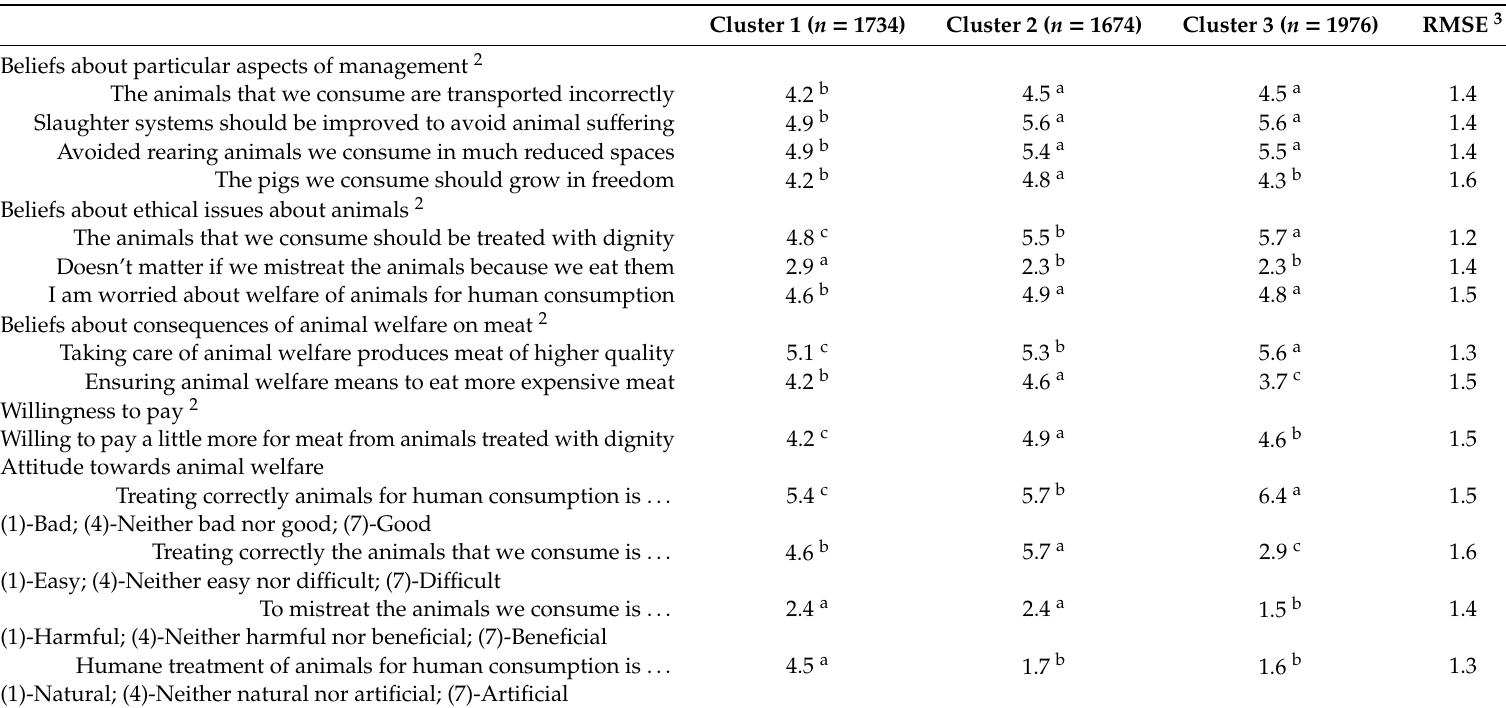
Table 7. Description of the three clusters regarding beliefs, willingness to pay, and attitudes toward castration and meat from castrated pigs 1 . Cluster 1 ( n = 1734) Cluster 2 ( n = 1674) Cluster 3 ( n = 1976) RMSE